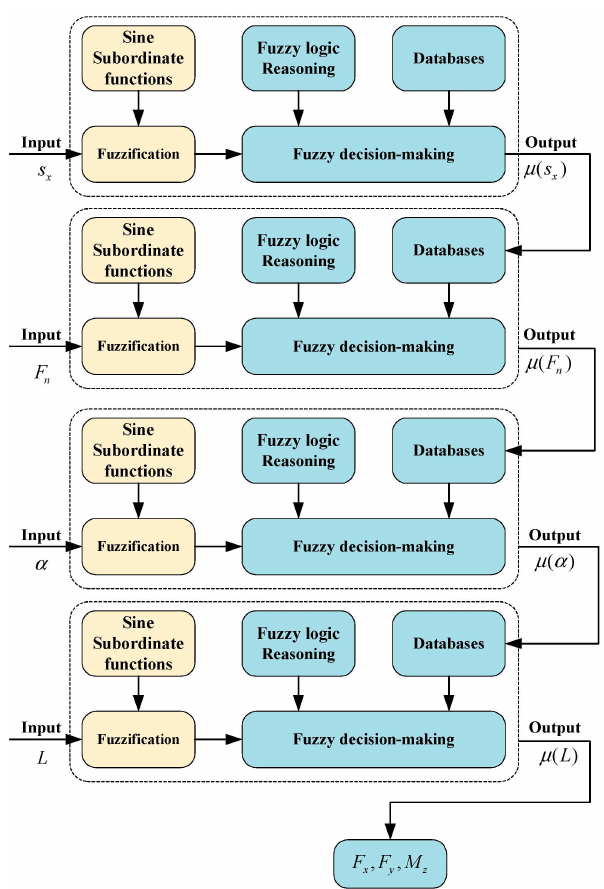
Figure 5. Adaptive parameter-free tire model based on data driven